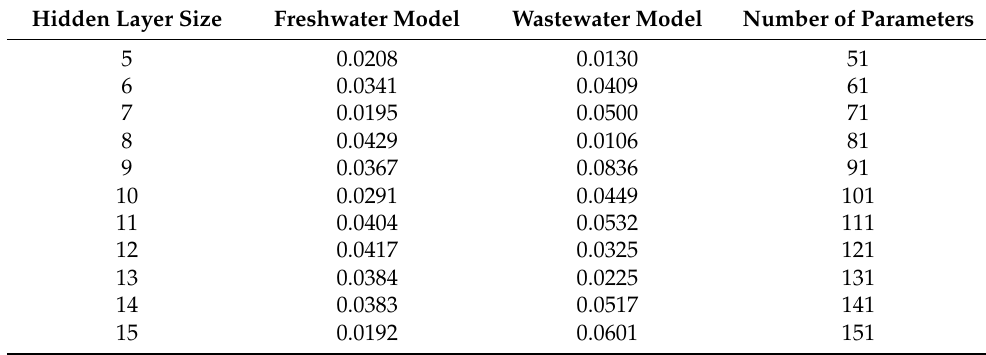
Table 4. Model test performance (MSE) for each hidden layer size. Hidden Layer